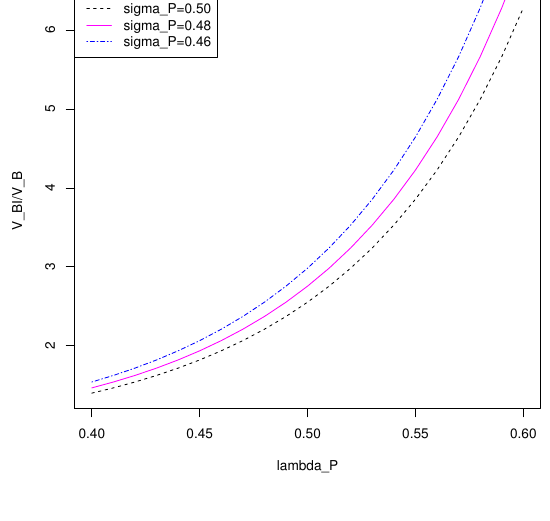
Figure 6. The impact of λ P .